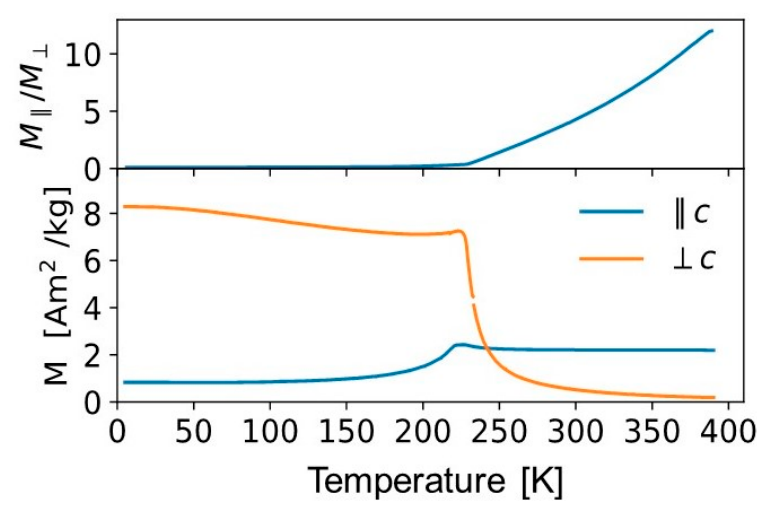
Figure 2. Temperature-dependent magnetization curves on a Mn 1.9 Co 0.1 Sb single crystal perpendicular and parallel to the c direction in a constant magnetic field µ 0 H = 0.01 T ( bottom ) and the ratio of the magnetizations parallel and perpendicular to the c direction ( top ).